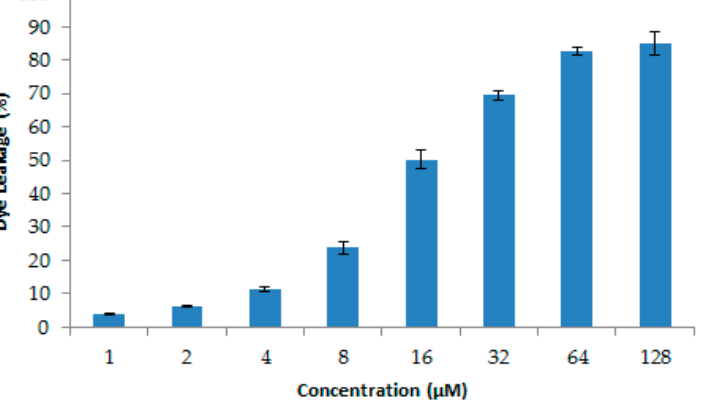
Figure 12. Release of calcein from CL/POPG (42:58) liposomes, with increasing concentration at 25 °C. Data are the average of at least three independent experiments ± S.D. Error bars represent the S.D. In the CLSM, LGH2 can be bound to the cell membrane of S. aureus , and the fluorescence